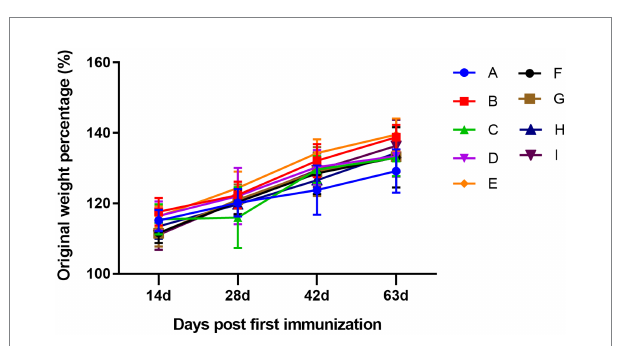
FIGURE 2 Dynamic changes in the percentage of original weight among groups. A, PBS group; B, influenza vaccination alone group; C, influenza vaccine and aluminum hydroxide co-immunized group; D, influenza vaccine and lentinan co-immunized group; E, influenza vaccine and panax notoginseng saponins co-immunized group; F, influenza vaccine and breviscapine co-immunized group; G, influenza vaccine and andrographolide co-immunized group; H, influenza vaccine and Astragali Radix co-immunized group; I, influenza vaccine and kangai co-immunized group. The letters in the following figures have the same